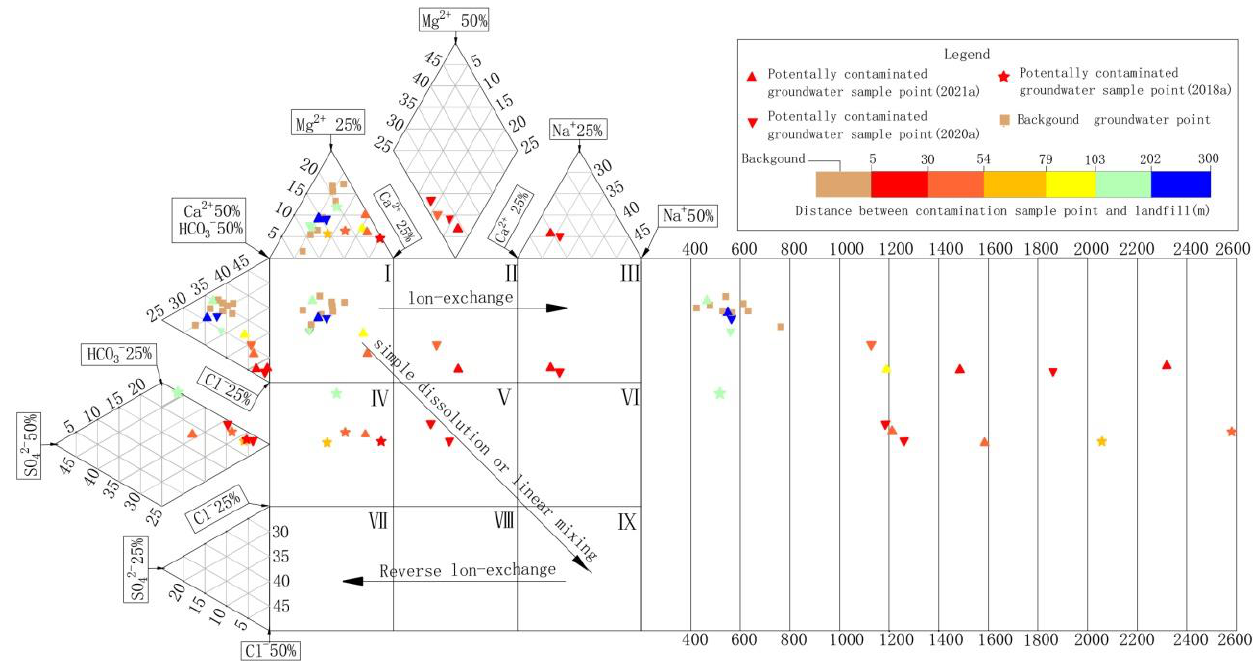
Figure 5. Expanded Durov diagram of groundwater in the study area.